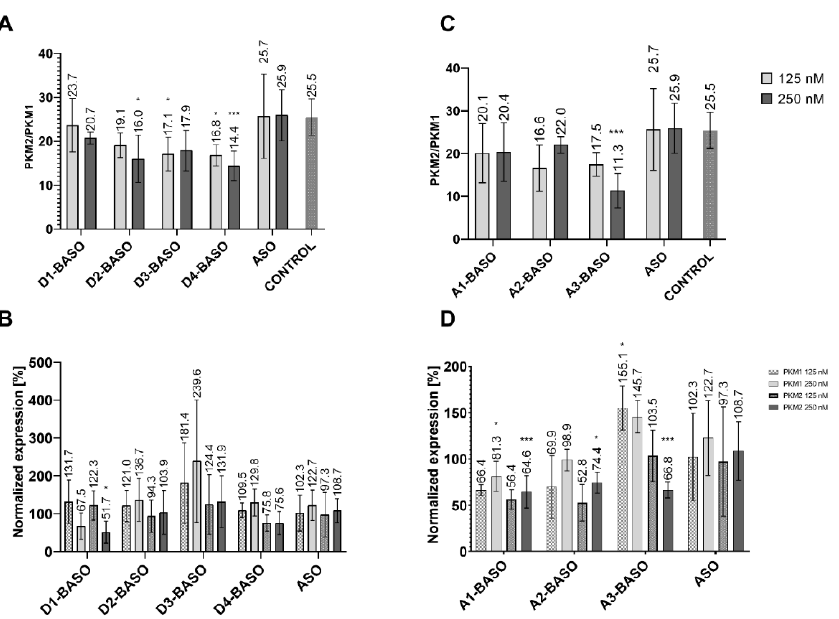
Figure 3. ( A ) The ratio of PKM2/PKM1 isoforms after transfection of UAGGU-based BASOs. ( B ) The PKM1 and PKM2 isoforms normalized expression after transfection of UAGGU-based BASOs. The normalized expression was calculated as a percentage of expression in non-transfected cells. ( C ) The ratio of PKM2/PKM1 isoforms after transfection of CAGGUAAGU-based BASOs. ( D ) The PKM1 and PKM2 isoforms normalized expression after transfection of CAGGUAAGU-based BASOs. The normalized expression was calculated as a percentage of expression in non-transfected cells. To obtain statistical significance, the BASOs results were compared with ASO-transfected cells. * indicates statistical significance at a level of p < 0.05; *** indicates statistical significance at a level of p < 0.01.